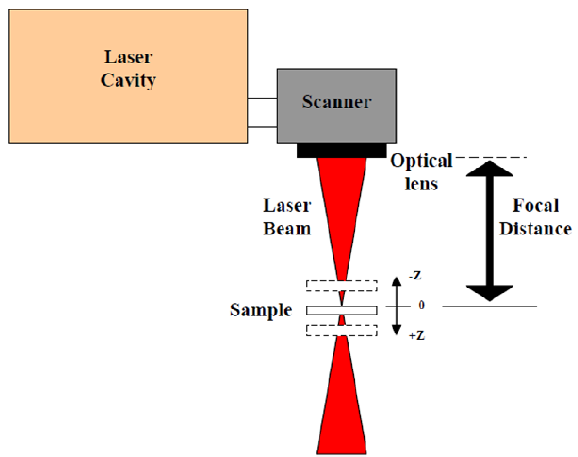
Figure 1. Sketch of the laser processing